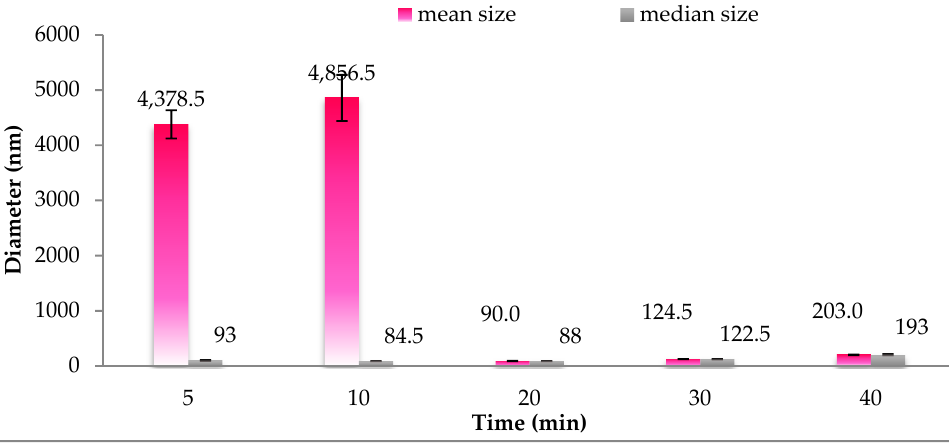
Figure 3. Size distribution of gac oil-loaded SLNs at different times of cold homogenization.